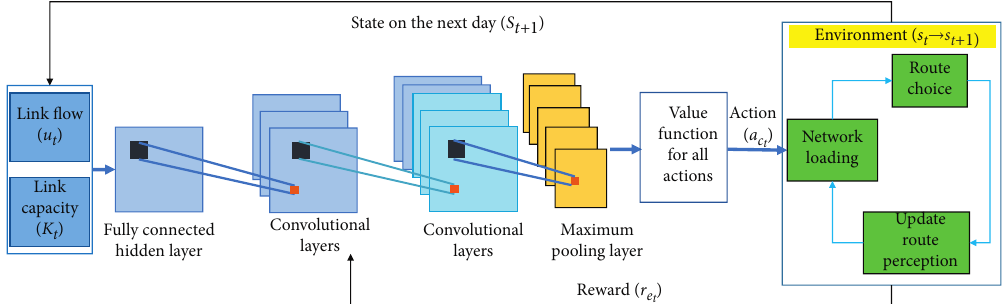
Figure 1: The deep Q-learning model used in the